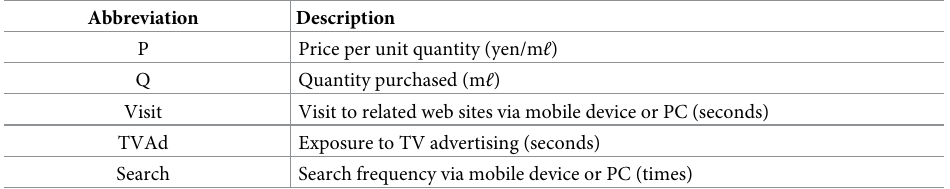
Table 1. Abbreviation and the description of the five kinds of time-series.